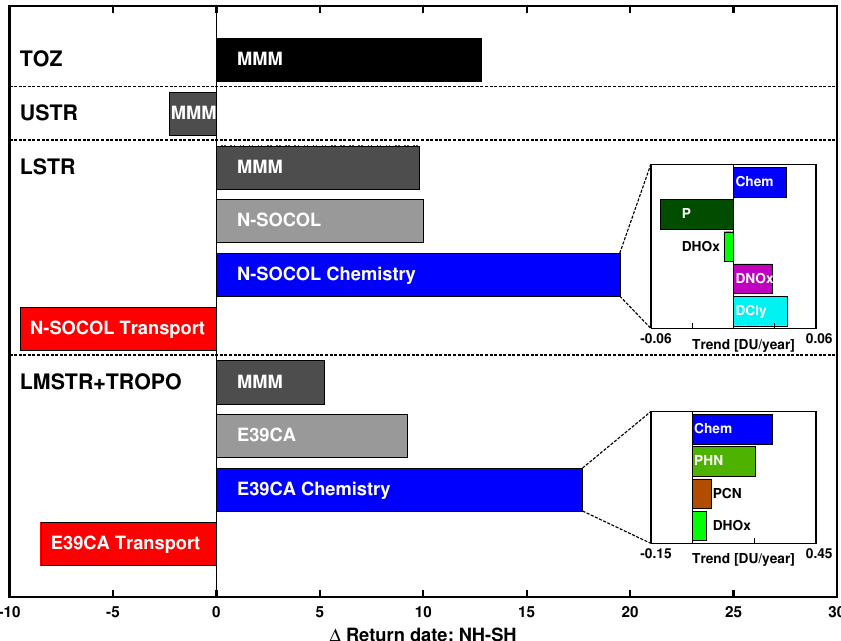
Fig. 16. Summary of the results: hemispheric differences in mid-latitude return dates to 1980 values are about 13yr in the multi-model mean (MMM) for TOZ. Upper stratospheric ozone contributed negatively to this difference, while return dates of lower stratospheric ozone (100 to 10hPa) alone have a hemispheric difference of about 10yr, and ozone below 100hPa contributes another 5yr. In the LSTR, in NIWA- SOCOL changes in chemistry only would lead to an earlier return in the NH of close to 20yr, and changes in transport of ozone offset the chemical effects. Attribution of chemically-induced trends in the LSTR show that the earlier return of NH ozone is due to changes in the NO x and Cl y cycles. In the lowermost stratosphere and troposphere, hemispheric differences modeled in E39CA, somewhat above-average, are attributed to changes in chemistry, and transport offsets the chemically-induced changes. Enhanced production of ozone in the NH by the NO x cycles is found to account for the stronger positive trend